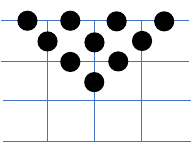
FIG. 6. Diagonals δ i for the 4 × 4 surface code. We consider the symmetry group R generated by reflections of the lattice against δ 1 and δ 5 . Note that any diagonal δ i is symmetric under reflections from R .